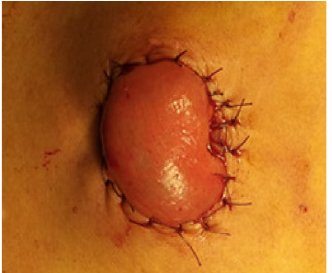
Figure 3. Both loops were fixed to the skin with 3/0 absorbable suture.